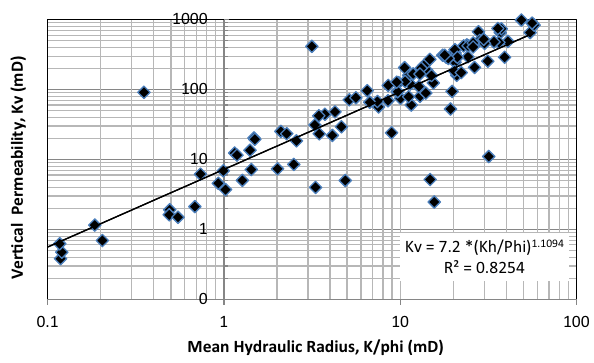
Fig. 6 Log–log plot of vertical permeability versus mean hydraulic